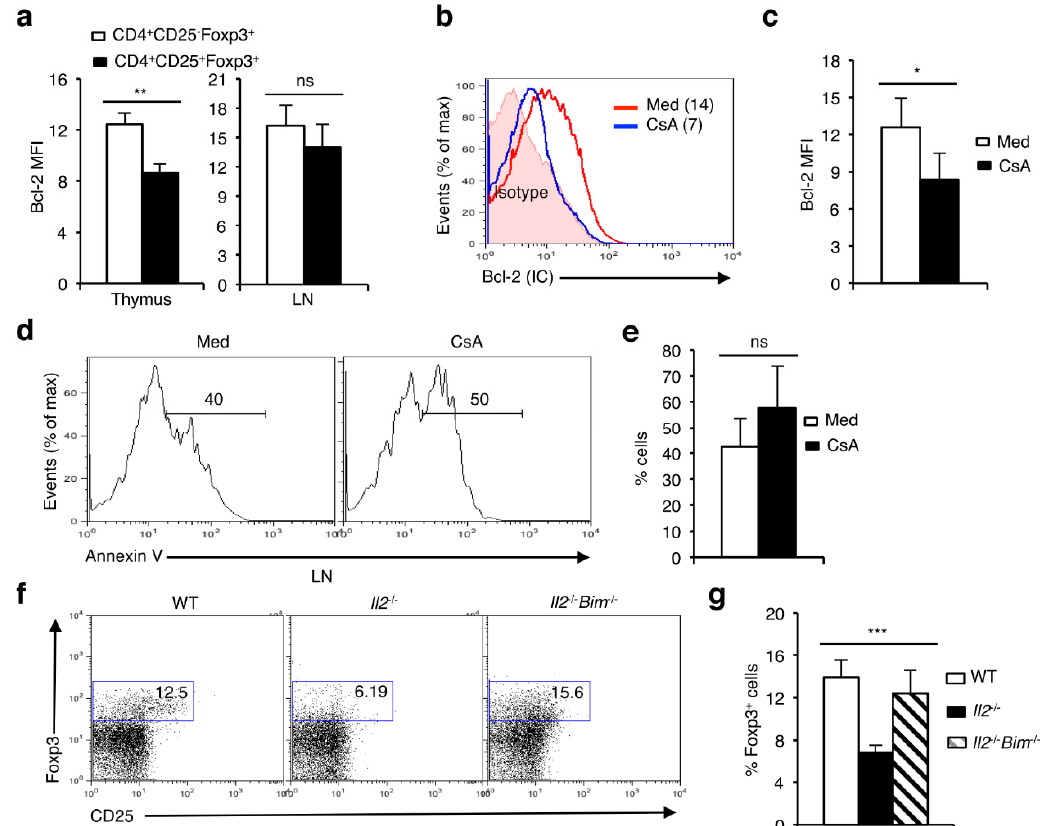
Figure 6. NFAT activity promotes survival and thereby the maintenance of Foxp3 + T reg cells. ( a ) Levels of Bcl-2 expression in CD4 + CD25 − Foxp3 + and CD4 + CD25 + Foxp3 + cells in the thymus (** p = 0.0045; unpaired t -test) and in LNs (ns = not significant; unpaired t -test) from WT mice. ( b ) Levels of Bcl-2 in CD4 + Foxp3 + cells from 24h NTOC in absence or presence of CsA. Numbers within the plot represent Bcl-2 MFI in respective conditions. ( c ) Quantification of Bcl-2 levels in CD4 + Foxp3 + cells from 24 h NTOC in absence or presence of CsA (* p = 0.0401; unpaired t -test). ( d ) Cell death in 24 h NTOC in absence or presence of CsA. ( e ) Quantification of cell death in WT 24h NTOC in untreated or CsA-treated lobes (ns = not significant; unpaired t -test). ( f ) Restoration of CD4 + Foxp3 + T reg population in Il2 -/- Bim -/- mice compared to Il2 -/- mice. ( g ) Quantification of percent CD4 + Foxp3 + T reg population in Il2 -/- Bim -/- mice compared to littermate control mice ( n = 7 WT, 6 Il2 -/- and 5 Il2 -/- Bim -/- mice, *** p < 0.0001; one-way ANOVA). Number inside each dot plot represents % Foxp3 + cells. Data are representative of three independent experiments and in ( a) , ( c ), ( e ) and ( g ) are presented as mean ± s.d.